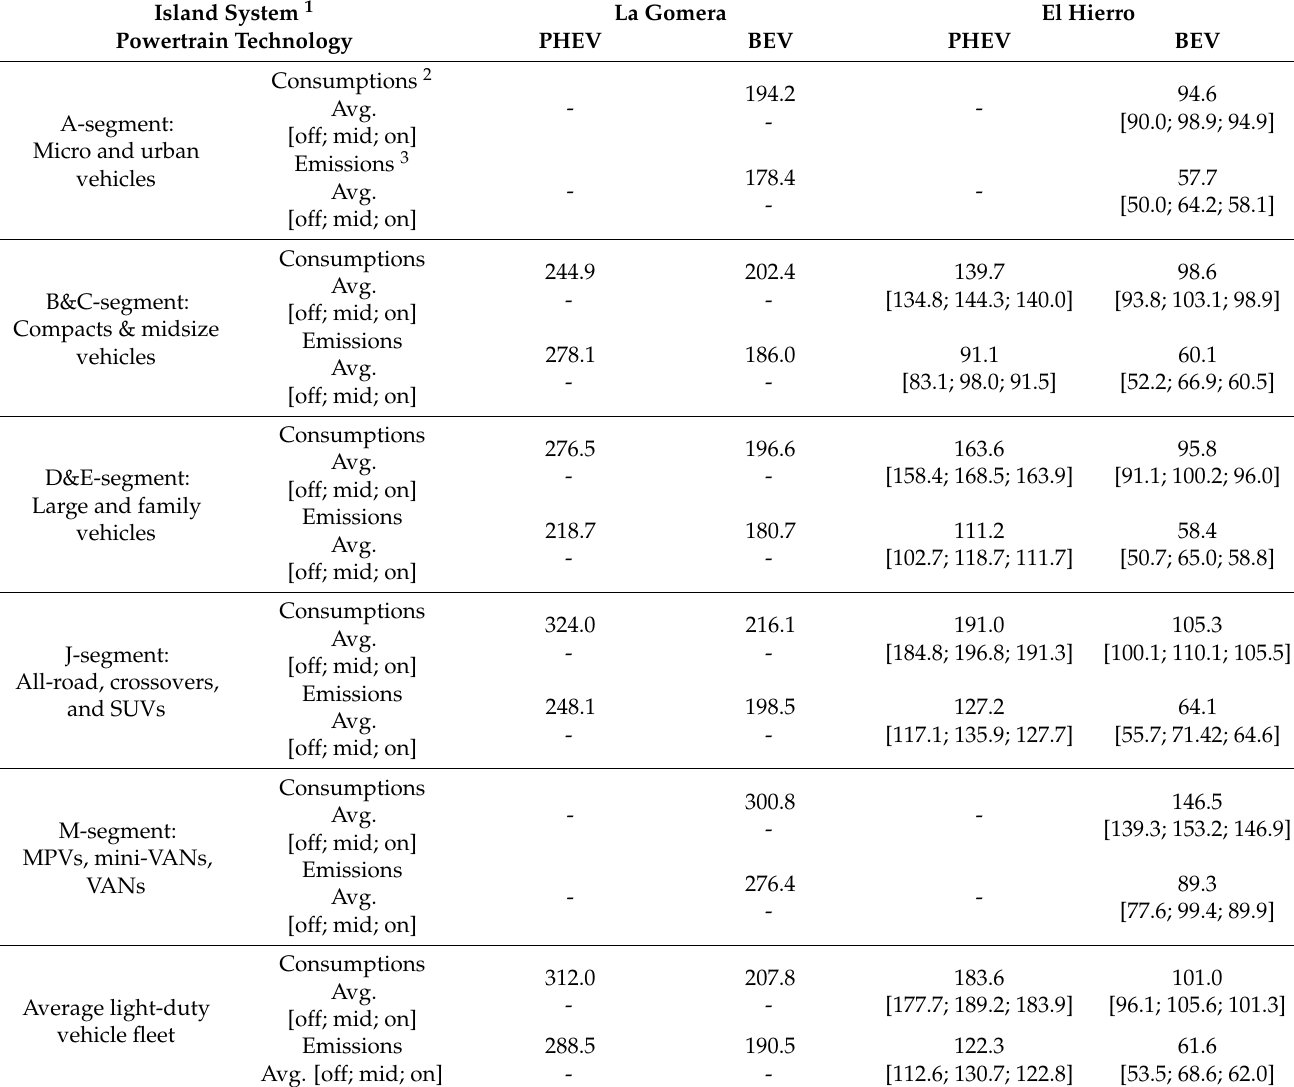
Table 8. The WtW results for PEVs on small-size systems (La Gomera and El Hierro in 2021). Island System 1 La Gomera El